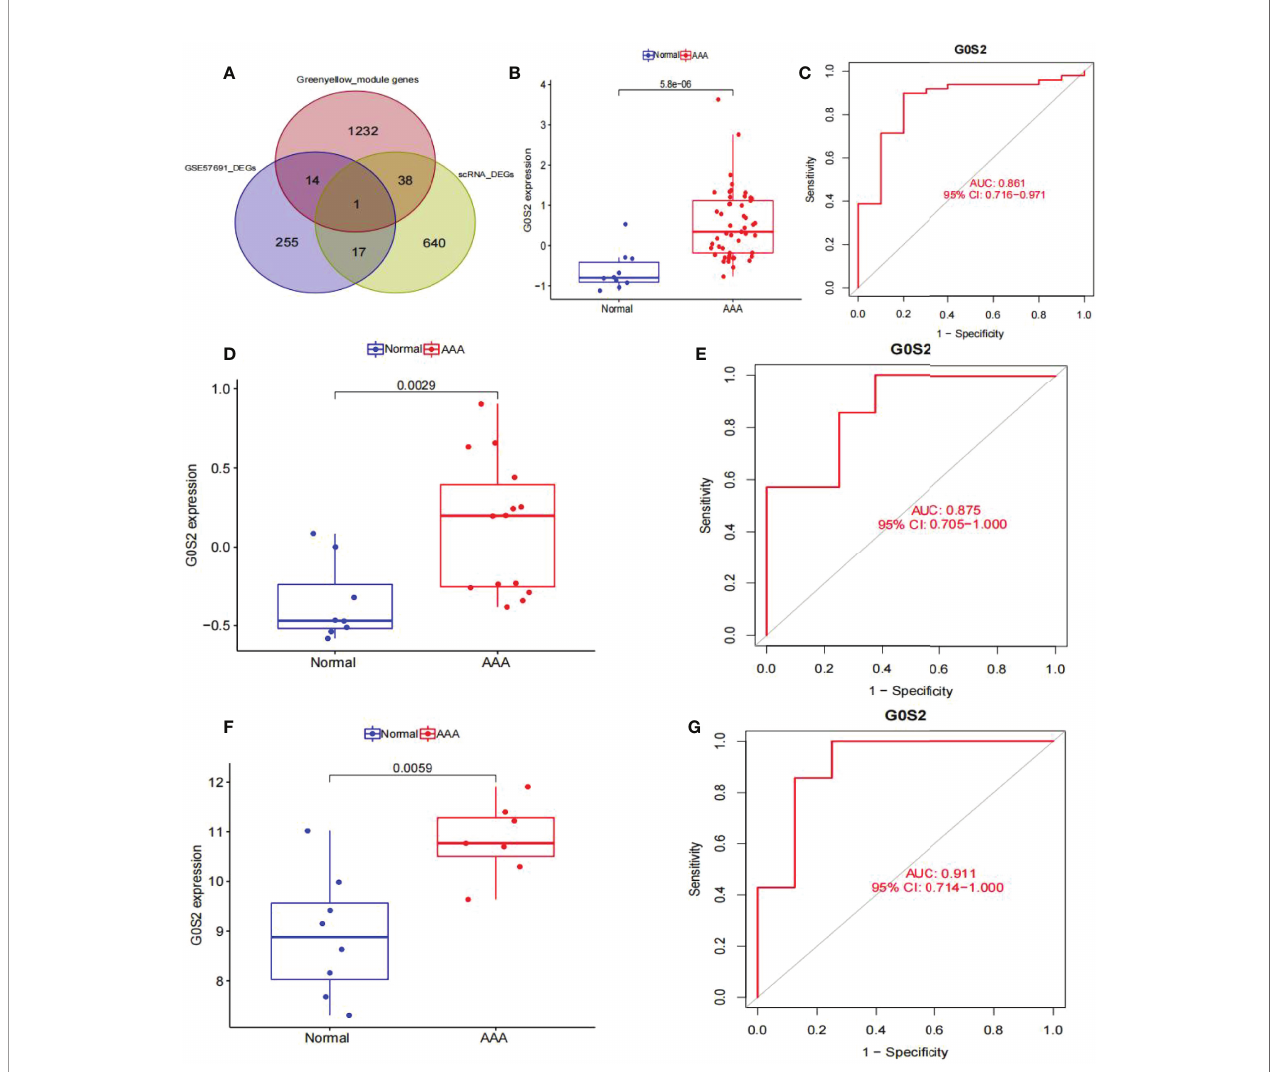
FIGURE 7 | Obtaining the key gene of AAA: G0S2 , by single-cell RNA-sequencing analysis, weighted co-expression network analysis, and differential expression analysis. (A) Intersection of single-cell analysis, WGCNA and differential expression analysis was displayed in a Venn diagram. The most signi fi cant gene, G0S2 , was obtained. (B) G0S2 mRNA expression in AAA compared to normal samples in the GSE57691. (C) ROC curve construction in public data sets to evaluate the diagnostic accuracy of G0S2 of AAA. The AUC of GSE57691 was 0.861. (D) G0S2 mRNA expression in AAA compared to normal samples in the GSE47472. (E) ROC curve construction in public data sets to evaluate the diagnostic accuracy of G0S2 of AAA. The AUC of GSE47472 was 0.875. (F) G0S2 mRNA expression in AAA compared to normal samples in the GSE7284. (G) ROC curve construction in public data sets to evaluate the diagnostic accuracy of G0S2 of AAA. The AUC of GSE7284 was 0.911. The distinction was considered good when the AUC value was between 0.8 and 0.9, and exceptional when the AUC value was > 0.9. ROC, receiver operating characteristic; AUC, area under the ROC curve; AAA, abdominal aortic